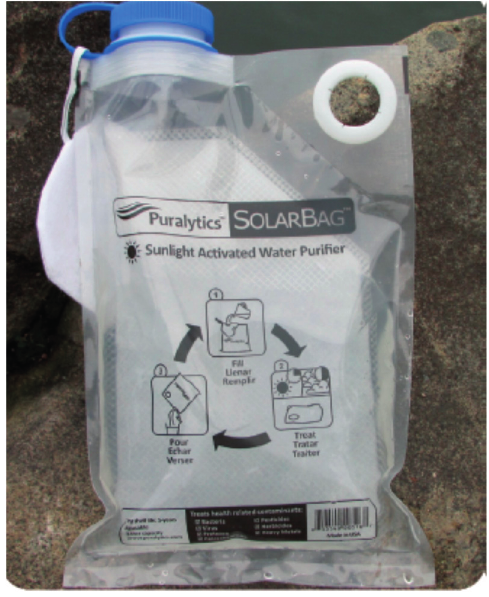
Figure 6. Solar bag commercially available from Puralytics, which utilizes photocatalysis (from Puralytics website